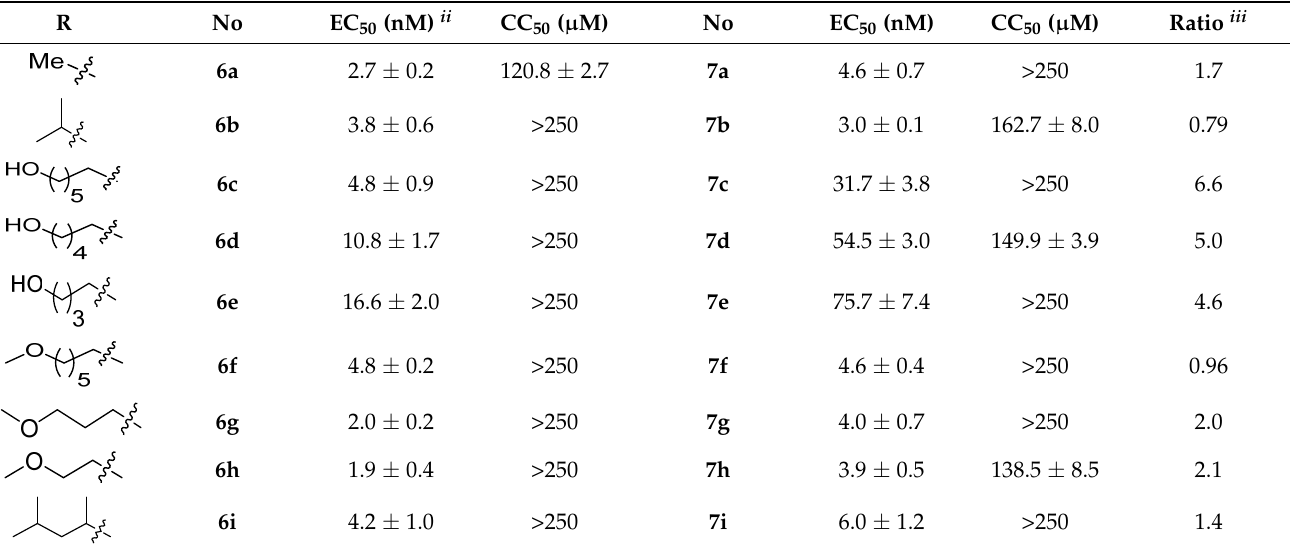
Table 1. Antiviral Potencies in Cells Infected with HIV-1 Vectors That Carry WT IN Mutants i . R